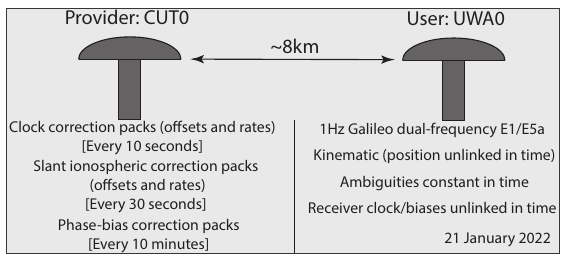
Figure 5. Single-station PPP-RTK setup for the experimental data-set. The temporal behaviour of the satellite clocks and ionospheric delays is modelled by a constant-velocity dynamic model with process noises’ standard deviations of 3 mm/ √ s 3 and 1 mm/ √ s 3 , respectively. The satellite phase biases are assumed to follow a random-walk (constant-state) process with a standard deviation of 0.01 cyc./ √